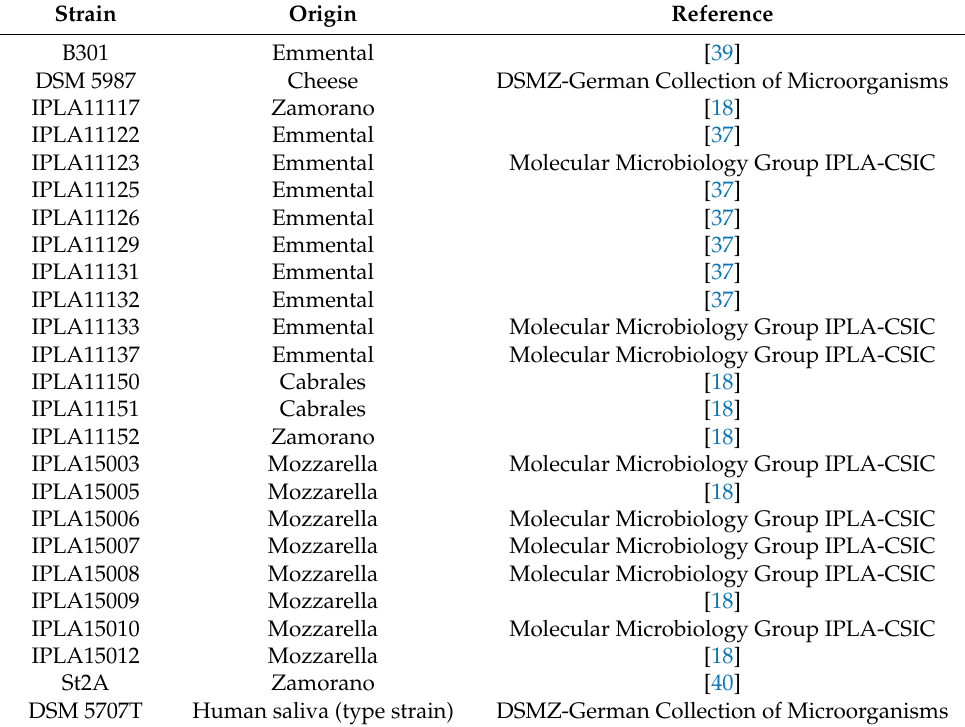
Table 1. Lentilactobacillus parabuchneri strains used in this